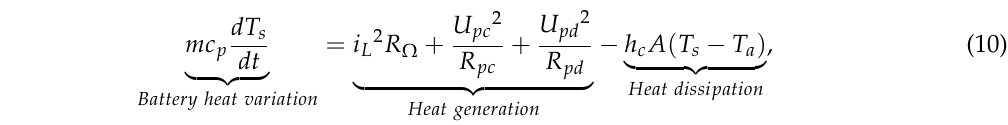
Figure 5. Second-order equivalent circuit model.